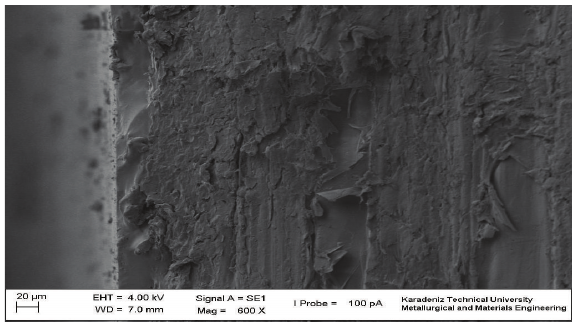
Figure 4: Cross section of sapwood beech